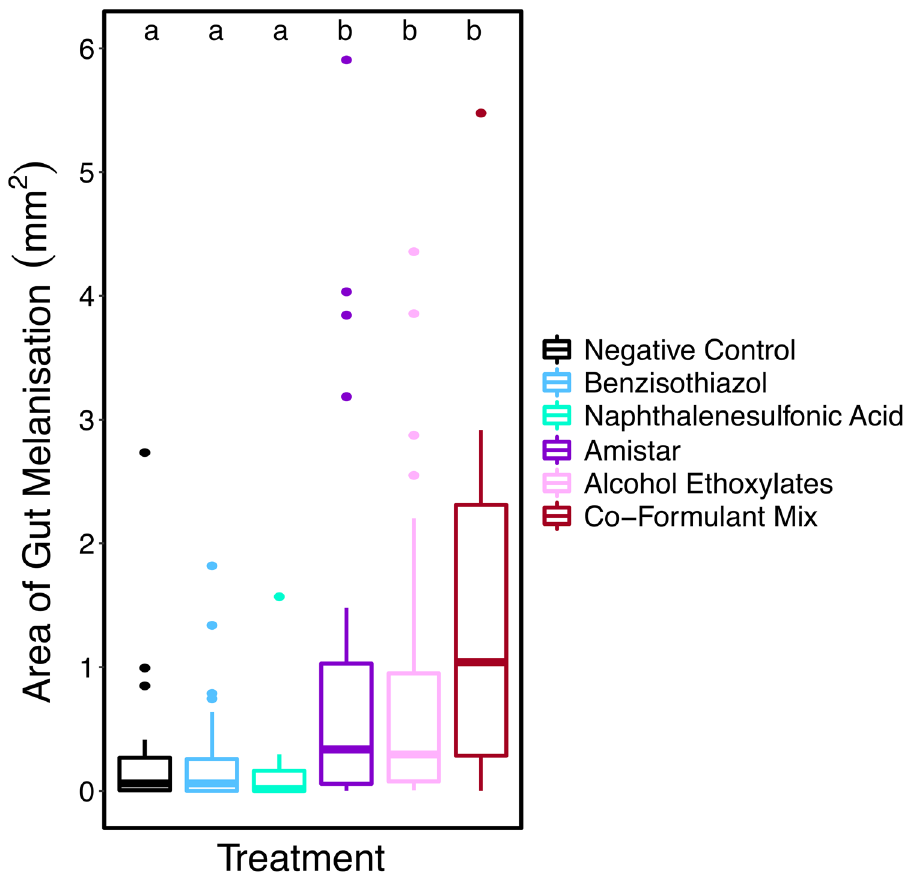
Figure 4. A boxplot showing area of gut melanisation, colour coded by treatment. Boxes represent the IQR, with the bold horizontal line the median value. The whiskers represent the furthest datapoint within 1.5 times the IQR and points beyond this are plotted as outliers. Different letters indicate statistically significant differences.